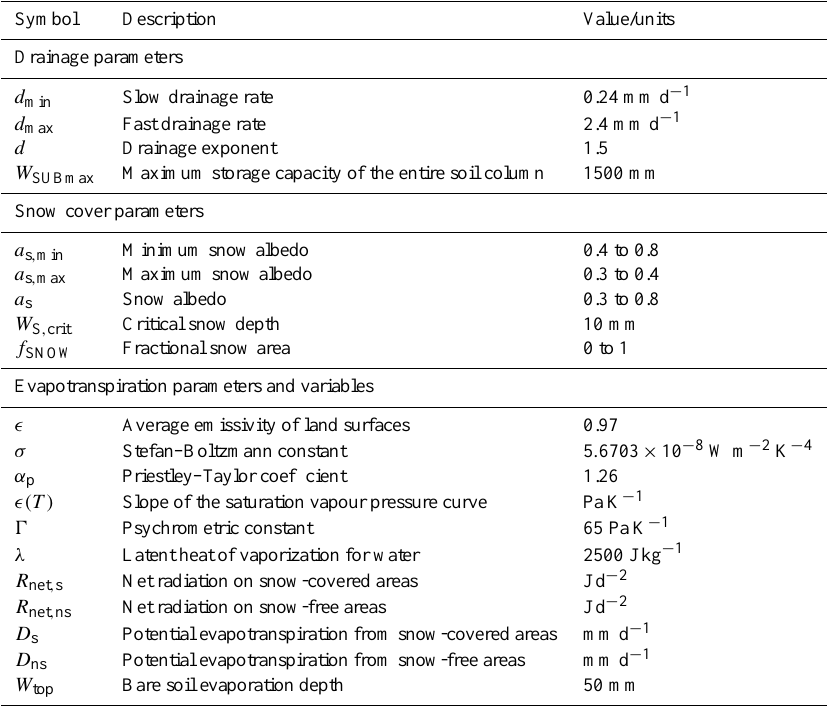
Table C7. Other parameters and variables of the land surface